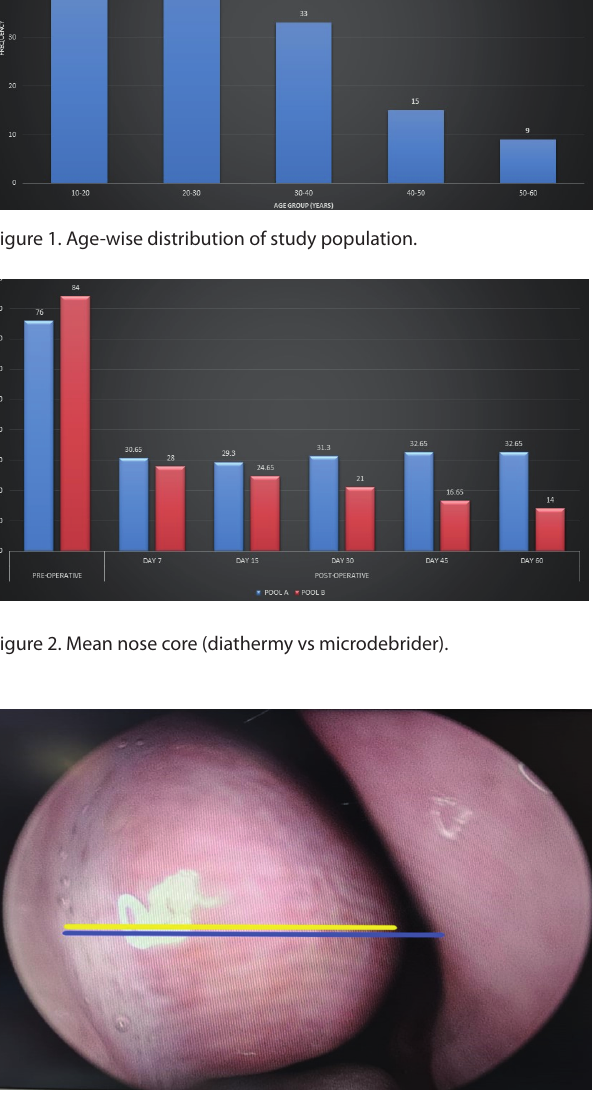
Figure 3. Percentage thickness of inferior turbinate(length of y llow lin in mm) as compar d to maximum width of inferior nasal valve area(length of blue line in mm) in Right nostril of pre-operative patient.